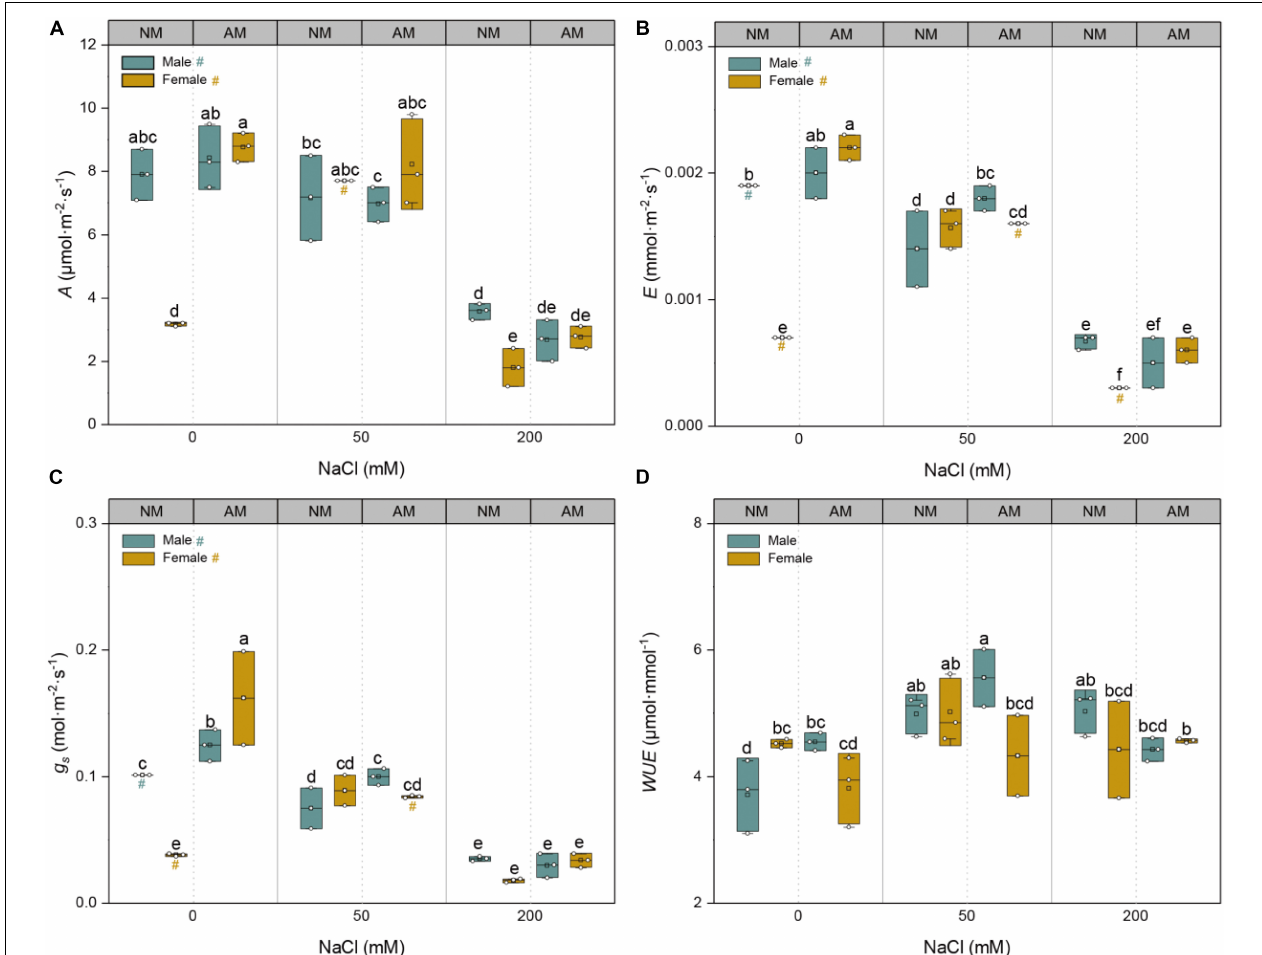
FIGURE 3 | Effects of arbuscular mycorrhizal fungus on net photosynthetic rate ( A ) (A) , stomatal conductance ( g s ) (B) , transpiration rate ( E ) (C) , and instantaneous water use efficiency (WUE) (D) in males and females of Morus alba under saline conditions. NM and AM represent inoculation with no mycorrhizal fungi and with Funneliformis mosseae , respectively. Values are presented as means ± SD ( n = 3). Three-way ANOVA is performed to compare the effects of sex, salt, and AM inoculation and their interactions in both males and females. Different letters indicate a significant difference according to least significant difference at p <